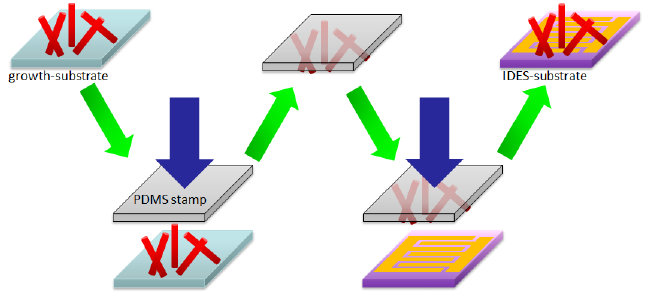
Figure 2. Nanowires printing transfer technology